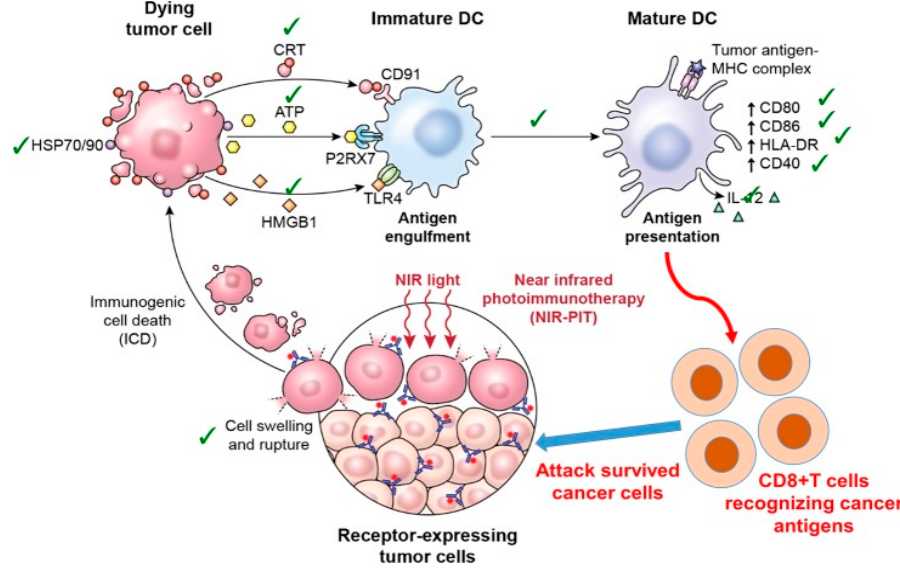
Figure 2. Near-infrared-Photoimmunotherapy ( NIR-PIT) induce immunogenic cell death (ICD) biologically which enhances the antitumor host immunity for treating cancerous cells. Reproduced from [70].